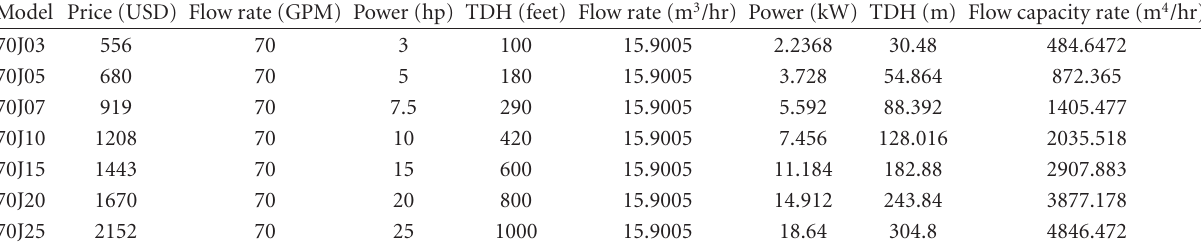
Data at best e ffi ciency (%62).